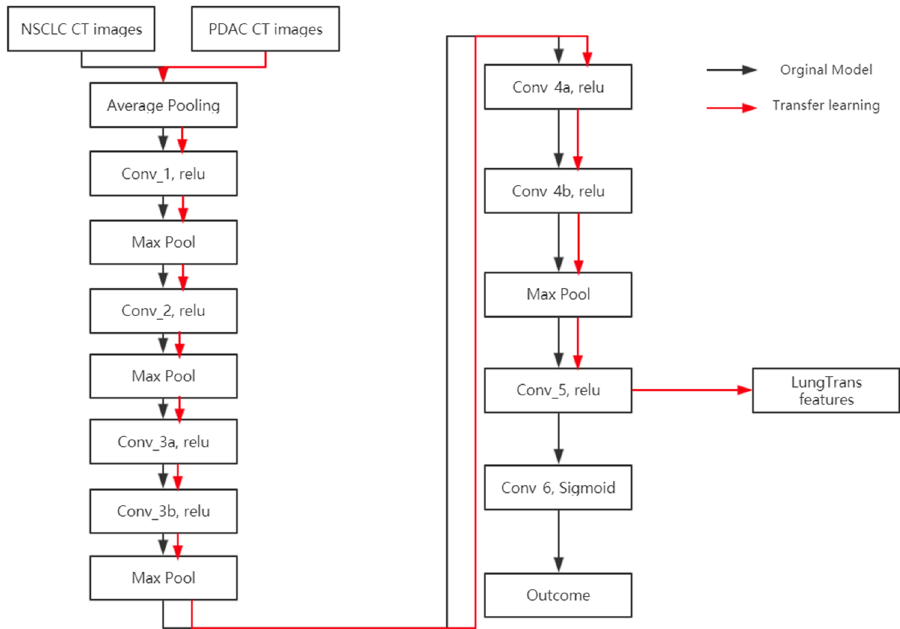
Figure 1. Architecture of the 8-layer CNN used to extract LungTrans